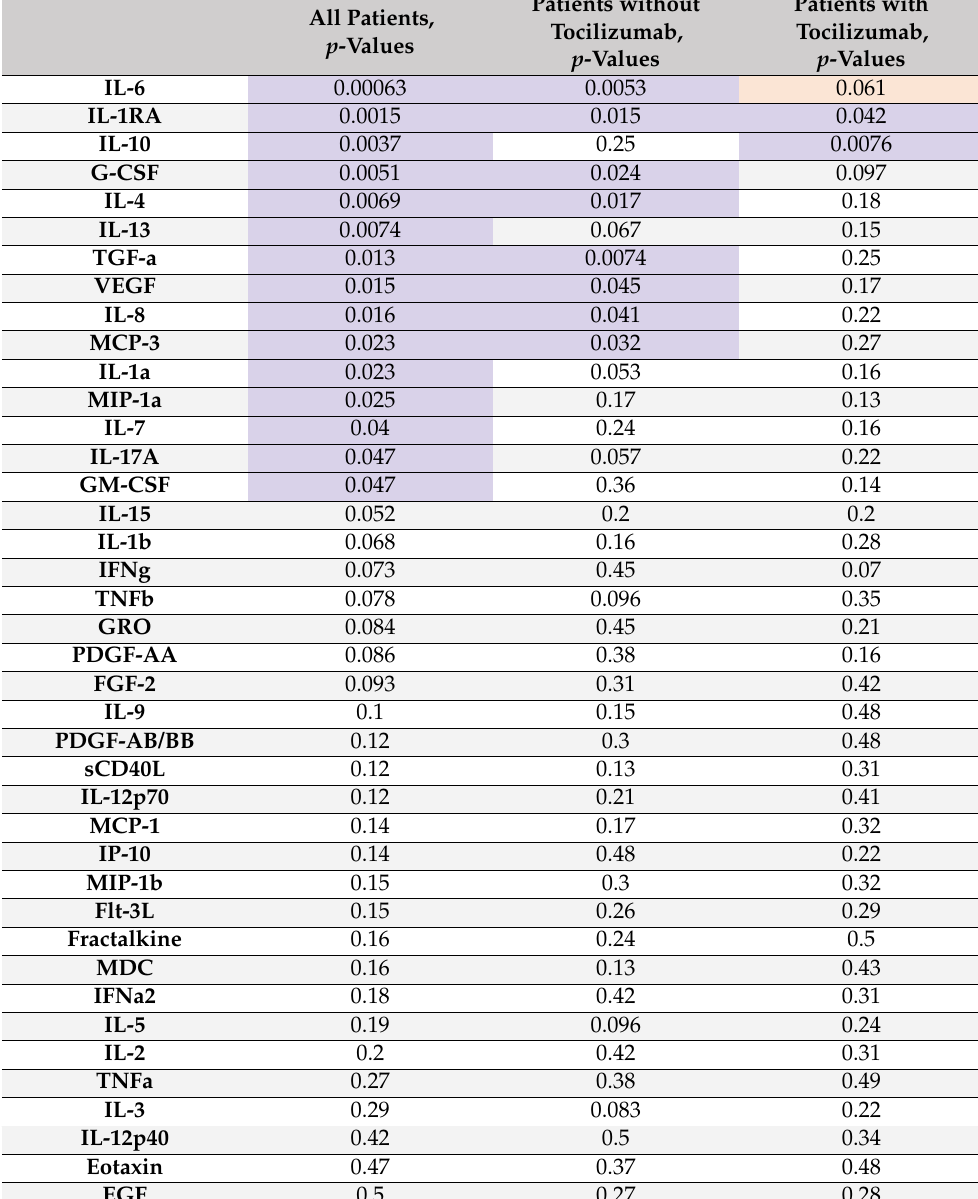
Table 5. Comparison of cytokine levels between patients with and without combined endpoint in all patients and separately in patients receiving tocilizumab. p -values are presented according to the Mann–Whitney